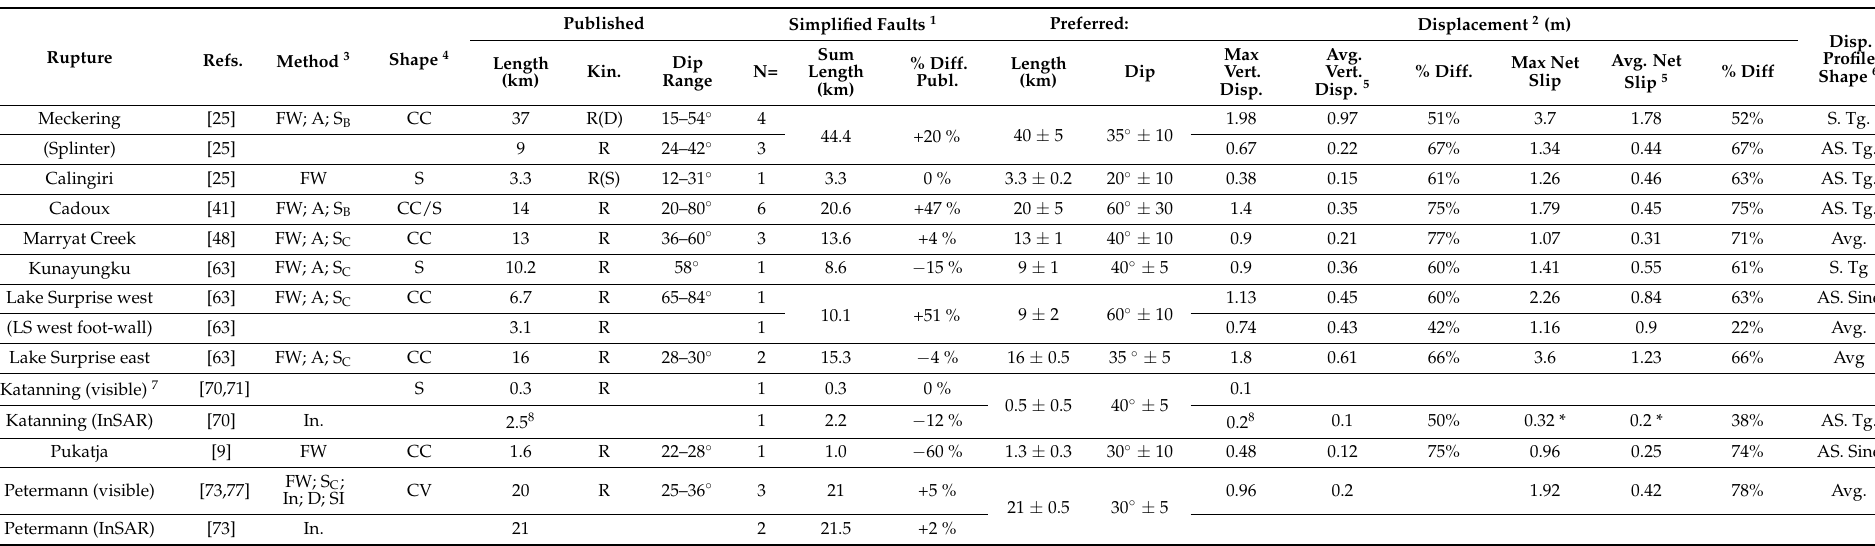
Table 6. Summary of surface measurements for each